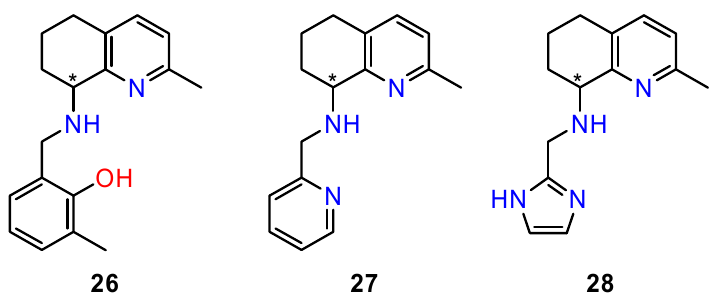
Figure 12. Structures of the tested tetrahydroquinoline amine derivatives. * stereogenic